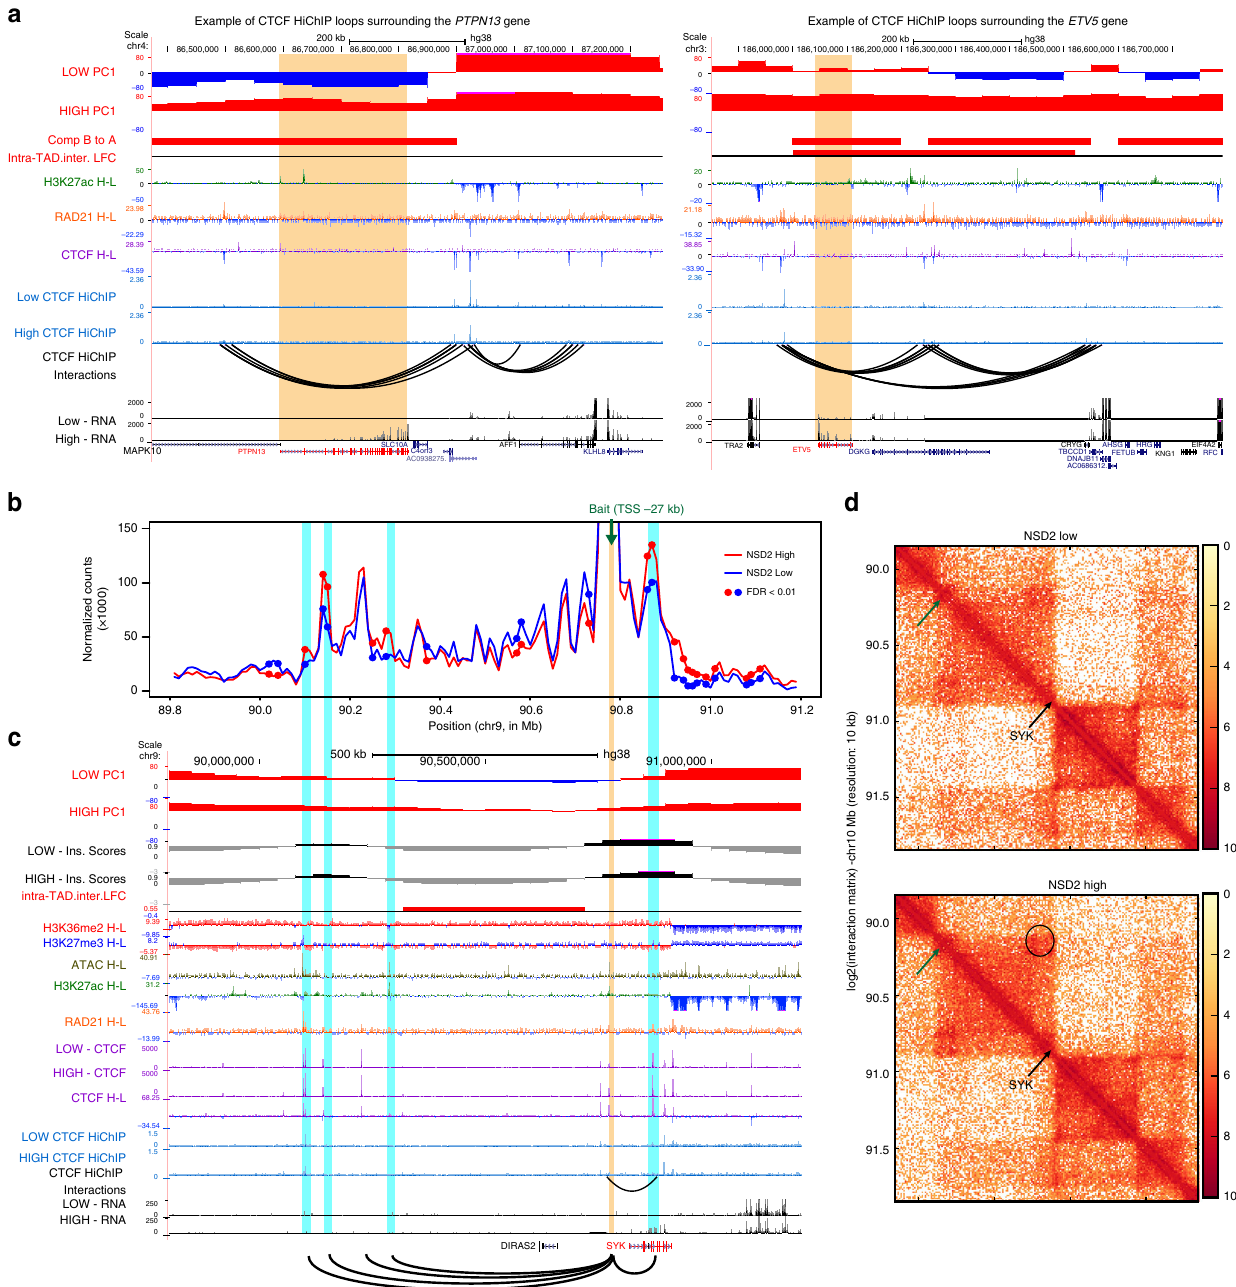
Fig. 6 Cells co-opt altered chromatin domains to drive oncogenic transcriptional programs. a UCSC tracks showing chromatin features and CTCF-mediated loop changes in the region surrounding the PTPN13 (left panel) and ETV5 (right panel) genes ( PTPN13 and ETV5 genes are indicated in red and highlighted with a yellow stripe). H – L refers to subtraction of the ChIP-seq signal (NSD2 High − Low). b Interaction pro fi le of a 4C bait located 27 kb downstream of the SYK promoter (green arrow, bait − 27 kb) in a 2.4 Mb region surrounding the SYK gene in NSD2 High (red line represents the average between two replicates) and Low (blue line represents the average between two replicates) cells using 4C counts in 20 kb sliding windows. DESeq2 analysis identi fi ed signi fi cantly different 4C signal in duplicated 4C samples from NSD2 High versus Low cells. Regions with differential interactions are indicated by red and blue dots ( n = 2 independent experiments, FDR < 0.01). c UCSC tracks showing chromatin features in the region surrounding SYK ( SYK indicated in red). A graphical representation of interactions from the 4C viewpoint (highlighted by a yellow strip) located 27 kb downstream of the SYK promoter is drawn with arcs at the bottom and highlighted by blue stripes. H – L refers to subtraction of the ChIP-seq signal (NSD2 High − Low). d Hi-C plots of the region surrounding SYK in NSD2 Low and High cells (left and right panels,